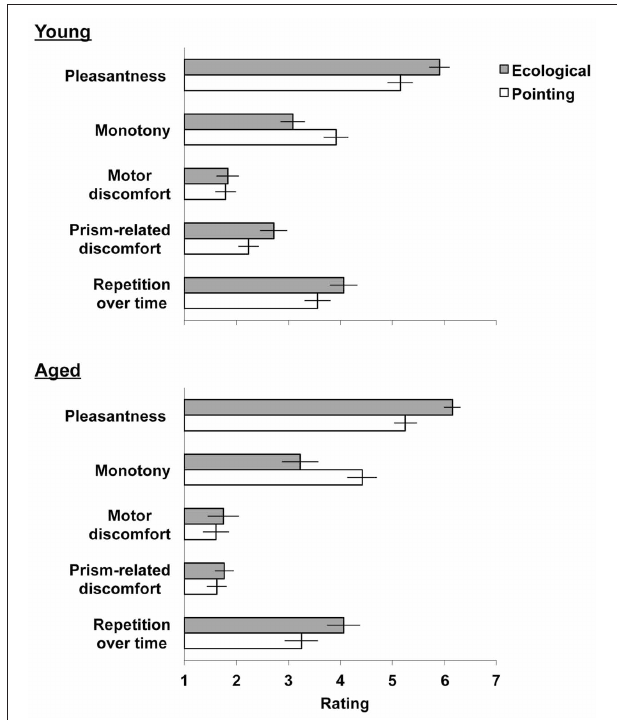
FIGURE 2 | Mean level of agreement scores ( SEM ) of the ecological (gray bars) and the pointing (white bars) prism adaptation procedures by the five questionnaire topics. Scale range: 1 (“totally disagree”) − 7 (“totally agree”).